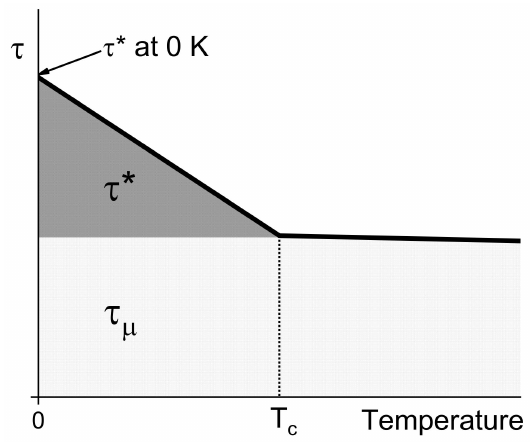
Figure 7. Temperature effect on the flow stress decomposed using additive